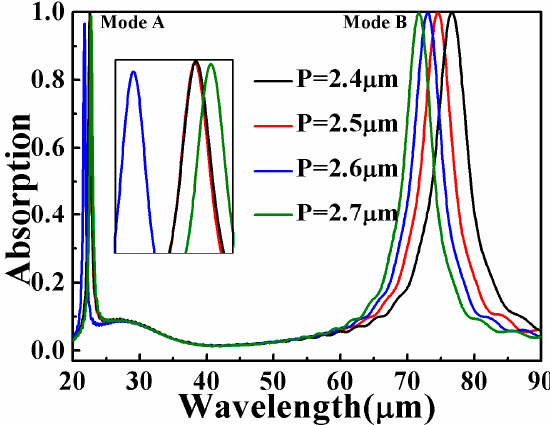
Figure 3. The effect of different parameters of the absorber on the absorption spectrum: ( a ) the outer ring radius of the graphene ( R out ); ( b ) L , ( c ) D , ( d ) G . The Fermi level of graphene is 1.0 eV in (b), (c), and (d). The insert graph is the absorption peak of Mode A or Mode B.